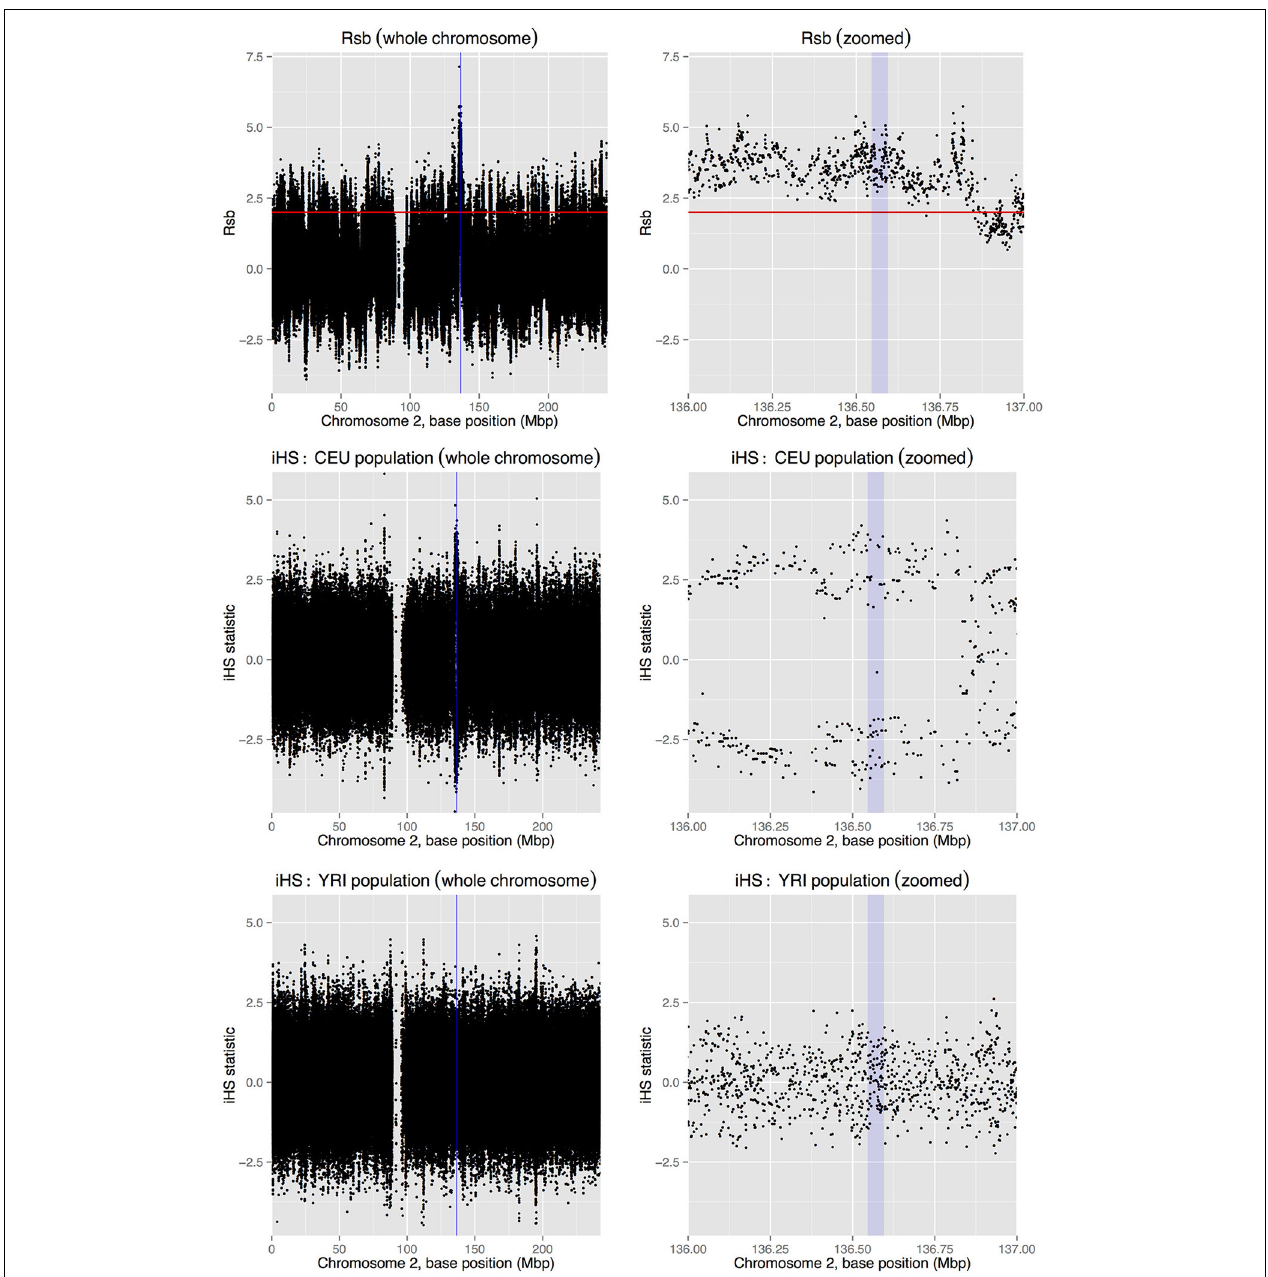
FIGURE 1 | Plots of Rsb (top row) and iHS (middle and bottom rows) values across chromosome 2 (whole chromosome in the left column, and the region around the LCT gene in the right column) based on 1000 Genomes Project data for the CEU and YRI populations. Blue vertical lines/boxes on the plots indicate the location of the LCT gene, and the red horizontal lines denote a p -value of less than 5% for any Rsb value above the line. The marked deviation of